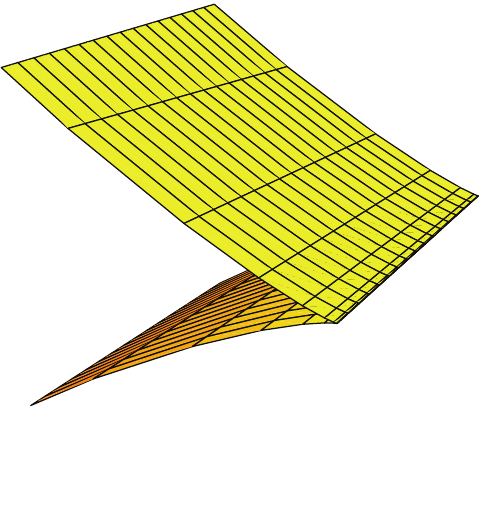
Figure 1: Cuspidal